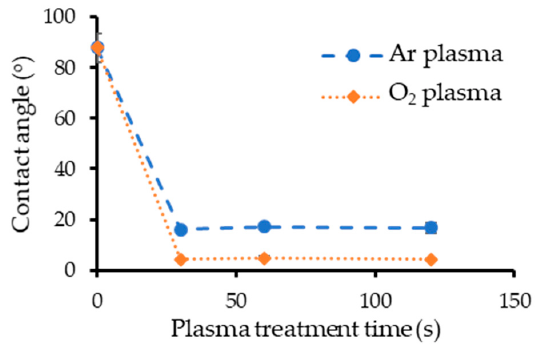
Figure 2. Measured contact angle vs. plasma treatment time.